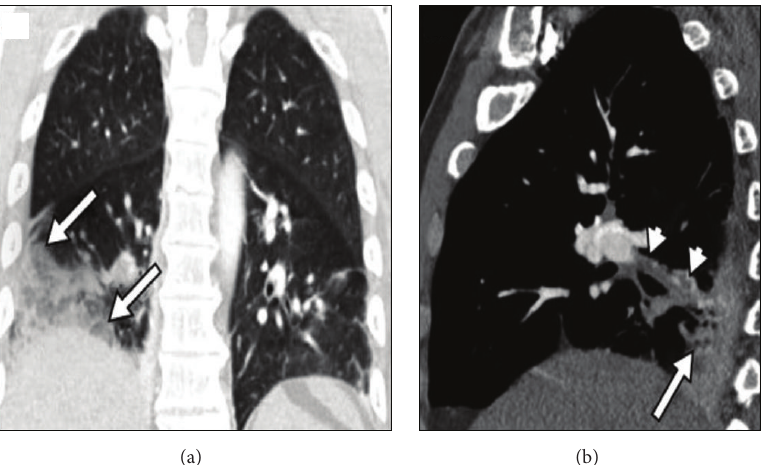
Figure 1: (a) Coronal CTA image in lung window shows infiltrate in the right lung base, suggestive of a peripherally located infarcted lung (arrows). (b) Sagittal CTA image shows embolism within the right lower lobe segmental branches (arrowheads) and the peripherally located infarcted lung (arrow) [10].